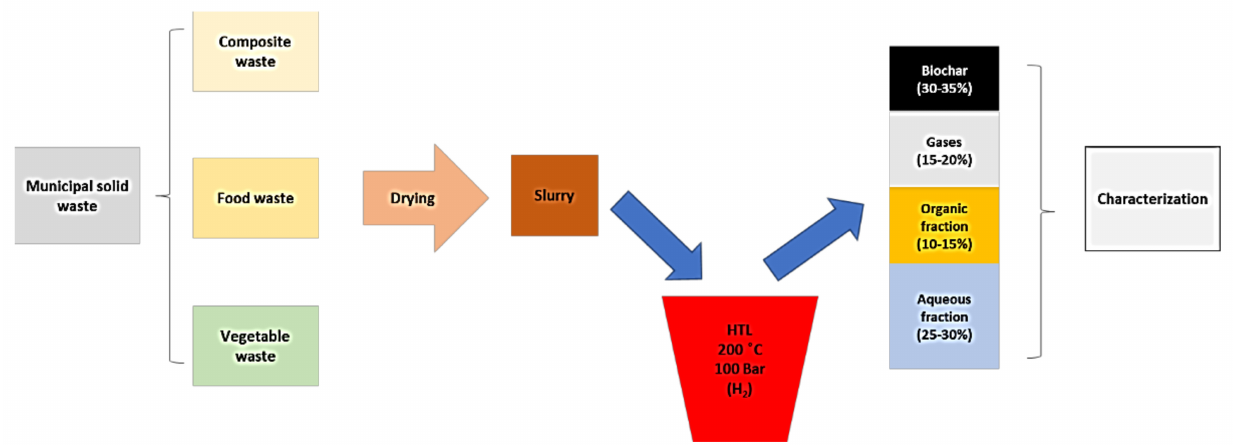
Figure 2. Descriptive diagram of the hydrothermal liquefaction (HTL) process from urban solid waste. Adapted from reference [90].